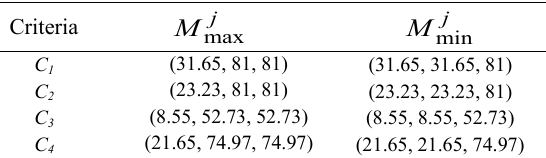
Table 9. The fuzzy maximum and the fuzzy minimum.